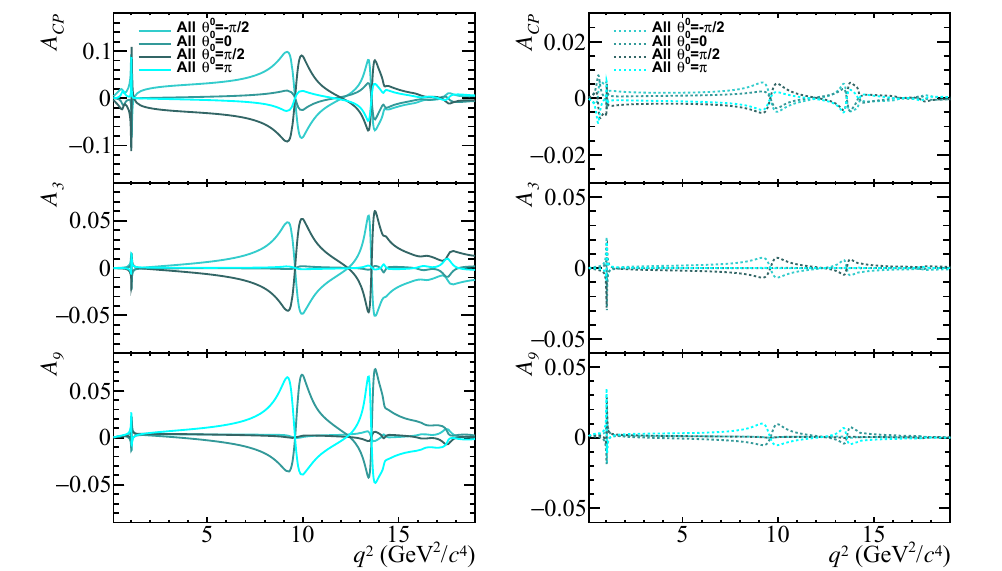
Fig. 4 Distribution of observables A CP , A 3 and A 9 as a function of q 2 , for θ 0 models are considered, one with C NP